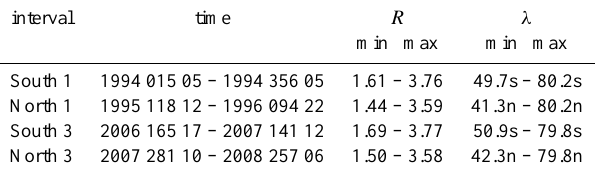
Table 1. Data intervals used to derive solar-rotation distributions of V : start and end times (year, day, hour), minimum and maximum distances ( R , in AU), and latitudes ( λ , in degrees, with n and s for North and South,